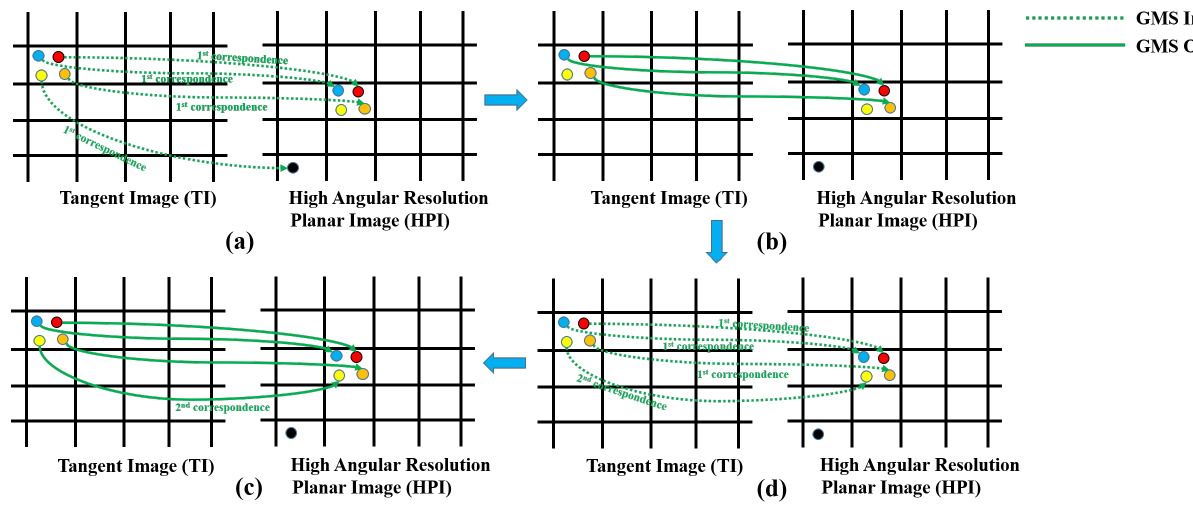
Figure 7. Proposed kNN-based GMS feature matcher illustration. We performed kNN matcher between the tangent image (TI) and the high angular resolution planar image (HPI) beforehand. We then ( a ) use the 1st correspondence to perform the first iteration of the GMS matcher. ( b ) shows the result of the first iteration. The yellow feature has 1st correspondence far from the neighbor correspondences; GMS did not identify it as correct matches (i.e., no green line for the yellow feature). ( c ) showed the preparation for the second iteration of GMS matcher with the yellow feature is now switched to its 2nd correspondence. ( d ) As the 2nd correspondence is close to the neighbor correspondences, GMS would identify it as correct matches (i.e., green line for the yellow